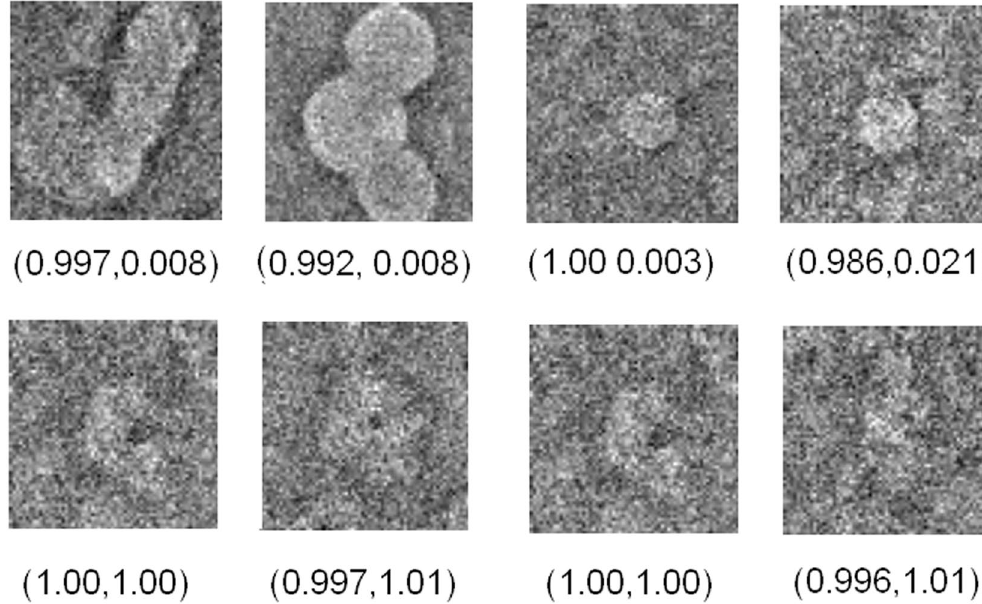
Figure 6. Exemplifying set of downsampled β -galactosidase particles showing high precision but low accuracy in the first row and both high precision and accuracy in the second row.